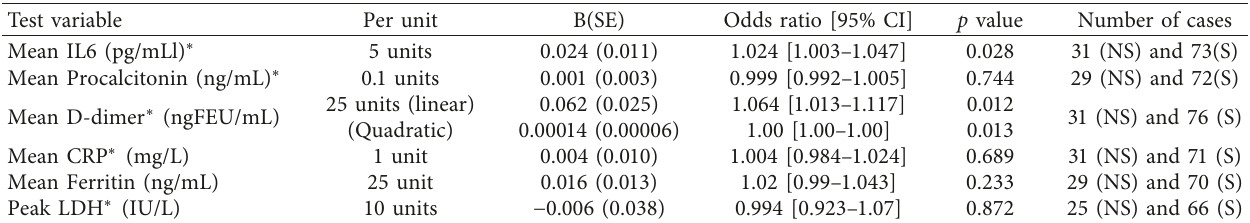
Table 6: Multivariable logistic regression (MLR) analysis to evaluate independent effect of each biomarker on survivor status. Test